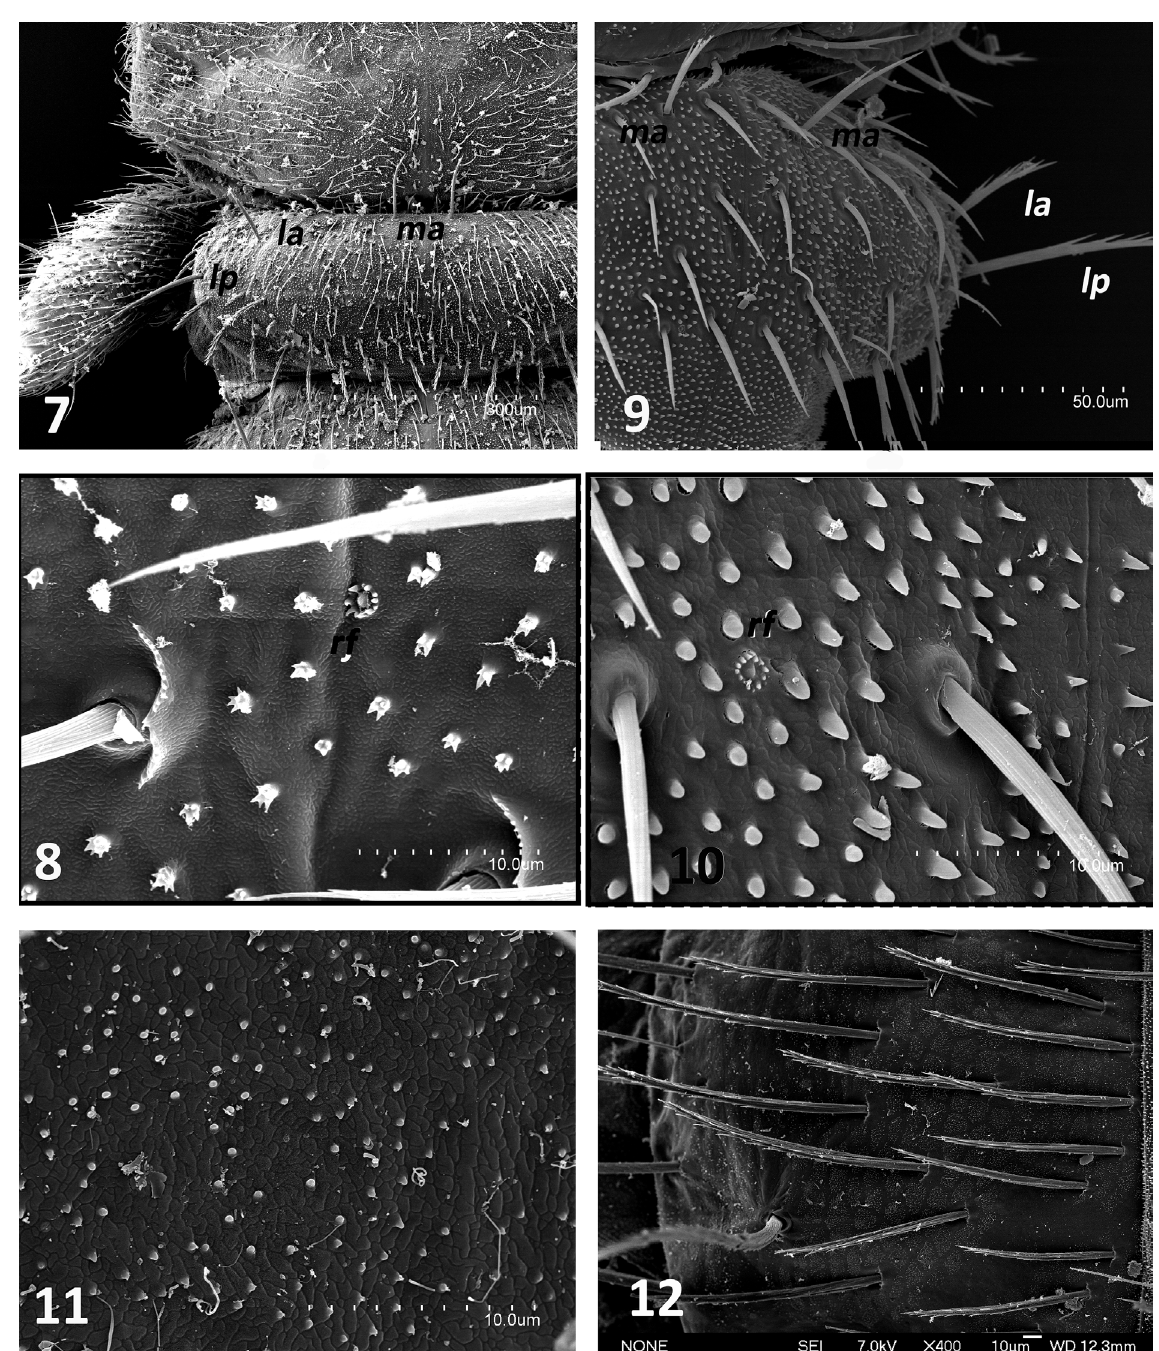
Figs 7–12. – 7–8 . Campodea ( Campodea ) pieltaini Silvestri, 1932. 7 . Pronotum, left side. 8 . Detail pronotum. – 9–10 . Campodea ( Paurocampa ) suensoni Tuxen, 1930. 9 . Pronotum, right side. 10 . Detail pronotum. – 11 . Campodea ( Campodea ) maestrazgoensis Sendra & Escolà, 2004, detail mesonotum. – 12 . Podocampa aff. fragiloides from Portugal caves, detail mesonotum. Abbreviations: see Material and